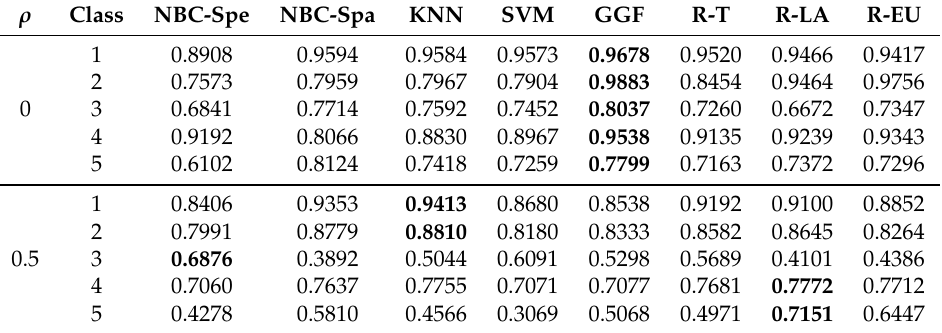
Table 6. Classification accuracy per class for the HYDICE Urban data set with different